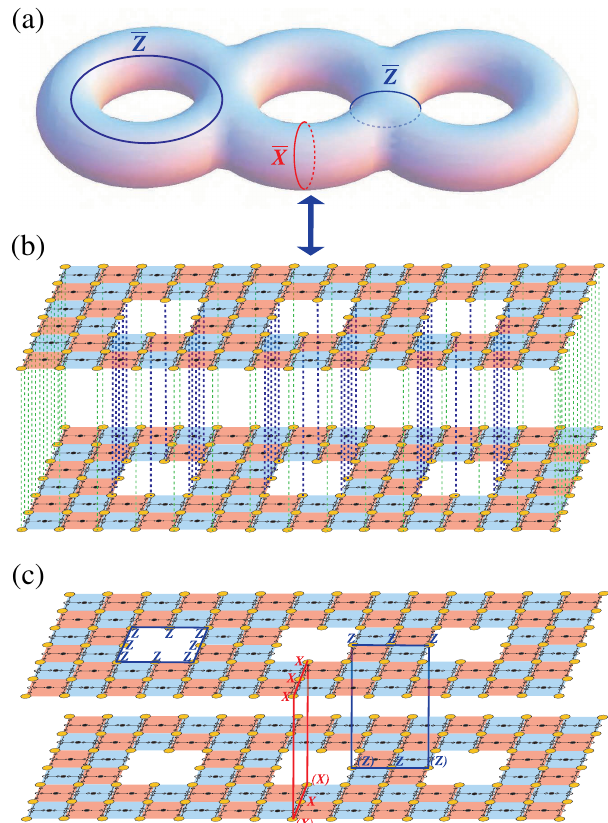
FIG. 20. (a) A g ¼ 3 surface with the illustration of logical strings on three noncontractible cycles. (b) Explicit construction of the g ¼ 3 surface by identifying the hole boundaries and outer edges of two layers of heavy-square topological codes. The blue and green dashed lines show the identification of the hole boundaries and outer edges, respectively. The vertically aligned plaquettes on the top and bottom layers have different types of stabilizers (indicated by different colors). (c) Logical strings corresponding to those shown in panel (a). The parentheses indicate Pauli operators identified with those on the top layers, which hence, should not be included when counting the weight of the logical Fig. 20(b) show all the identified data and syndrome measurement qubits. In particular, the blue dashed lines represent the gluing of the hole boundaries, and the green dashed lines represent the gluing of the outer edges of the two layers. Note that the X (red) and Z (blue) plaquettes aligned vertically are switched for the top and bottom layers, which makes sure that the neighbors of the X (red) plaquettes are always the Z (blue) plaquettes and vice versa.